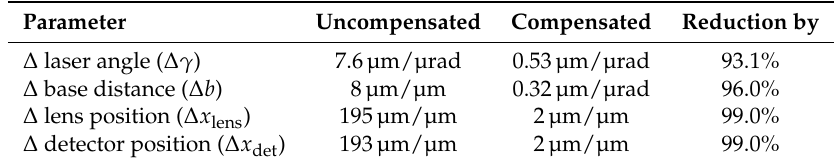
Table 2. Relationship between distance error ∆ d in dependence of parameter changes at a measurement distance of d =